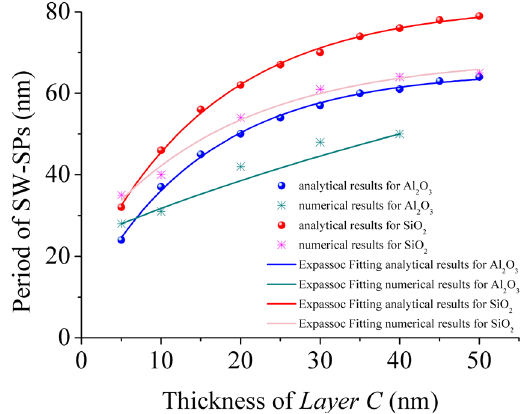
Figure 3. The period of plasmonic interference pattern as a function of the thickness of Layer C for different material combinations of Ag/Al